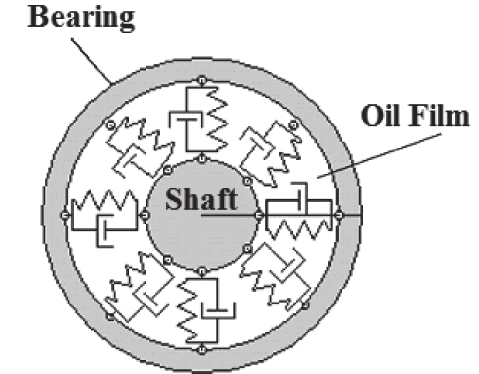
Figure 4 - Mathematical model for the hydrodynamic bearing.